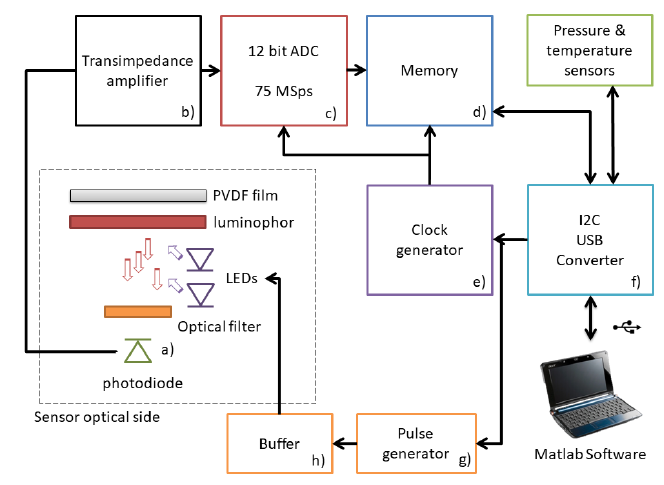
Figure 4. Block diagram of the electronic structure of the designed system. The Photodiode and the Transimpedence amplifier constitute the analog front end, while ADC, memory and I2C-USB interface are the digital section of the